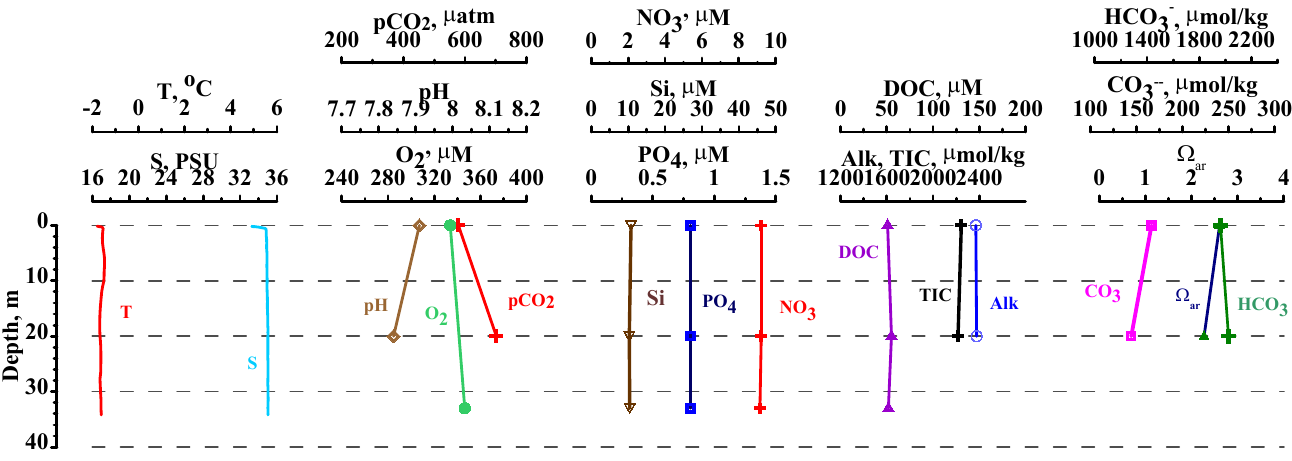
Figure A4. Vertical distribution of physical and chemical parameters at station TM2 (17 March 2014).